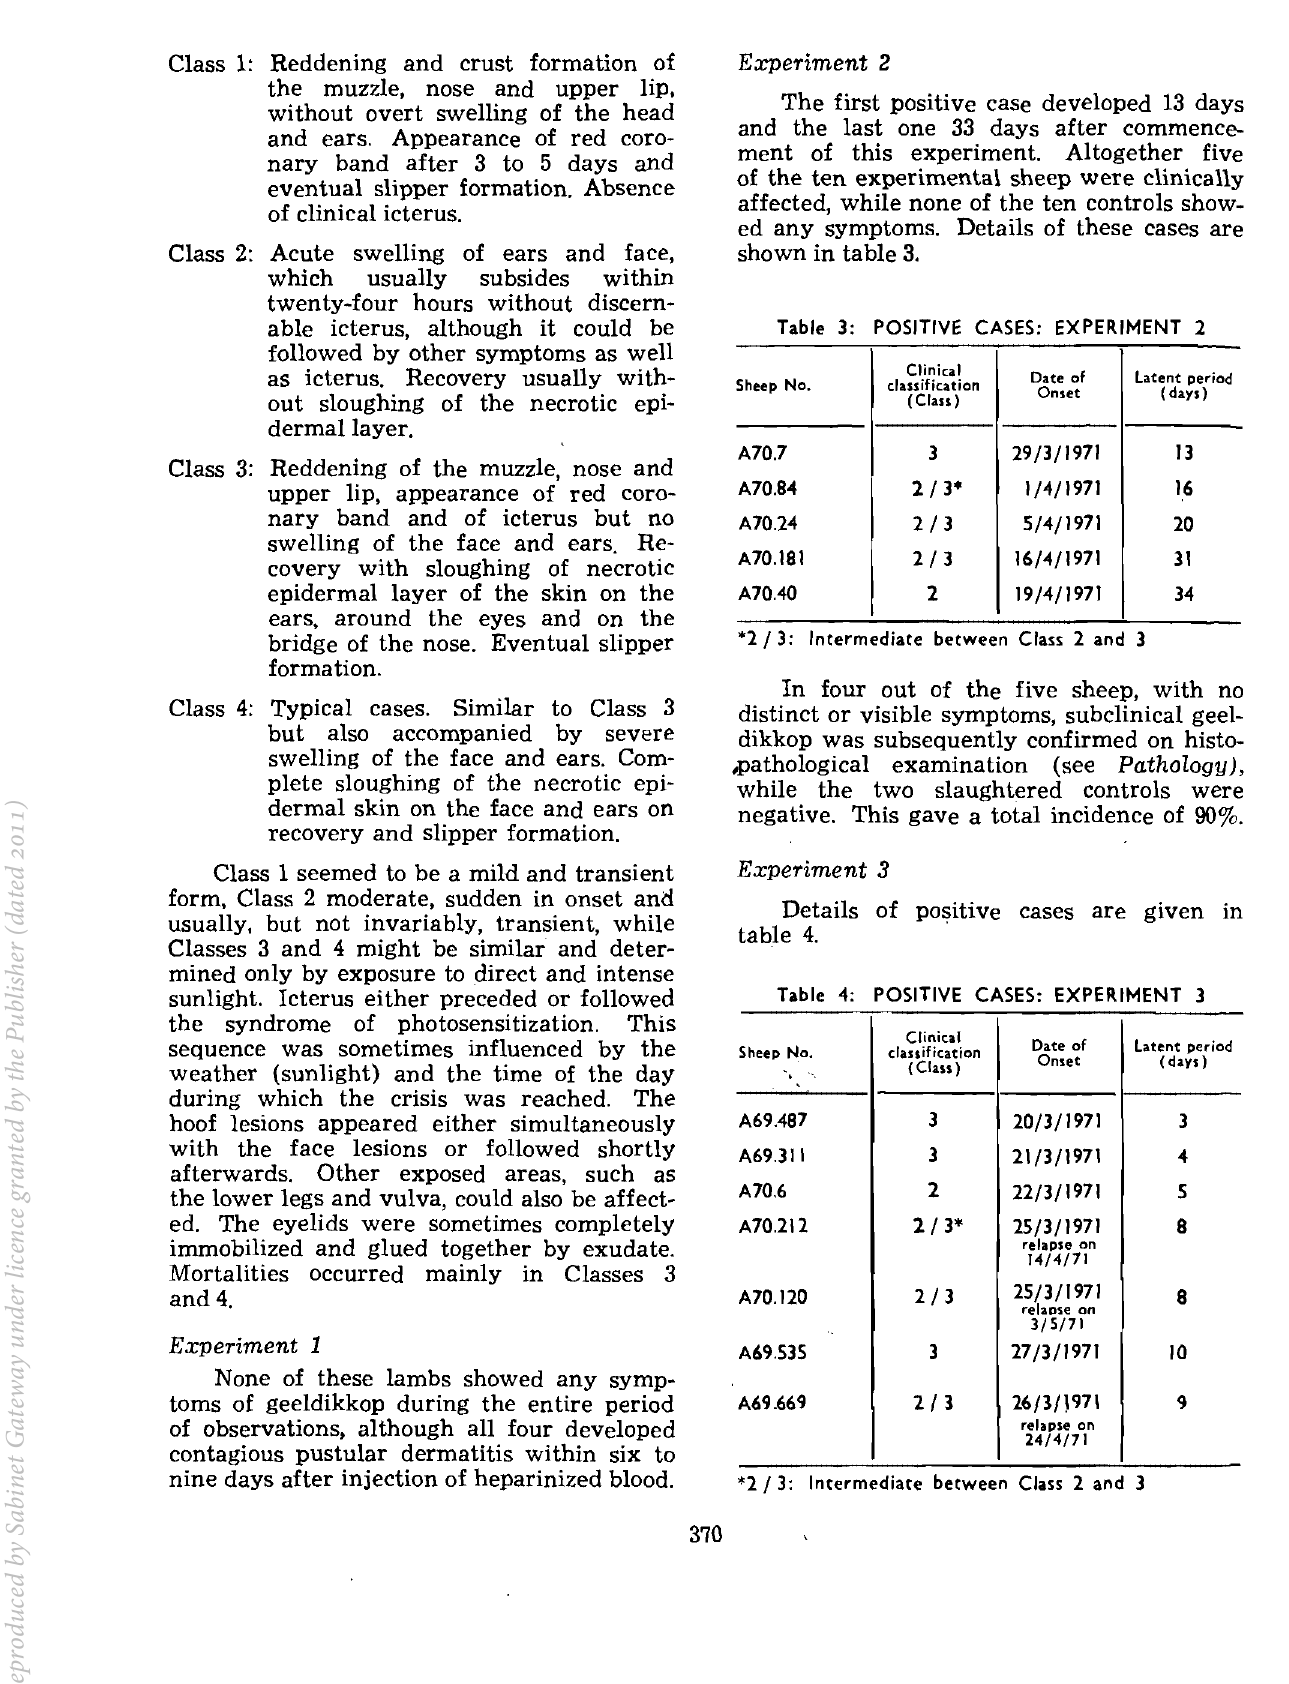
Table 3: POSITIVE CASES: EXPERIMENT 2